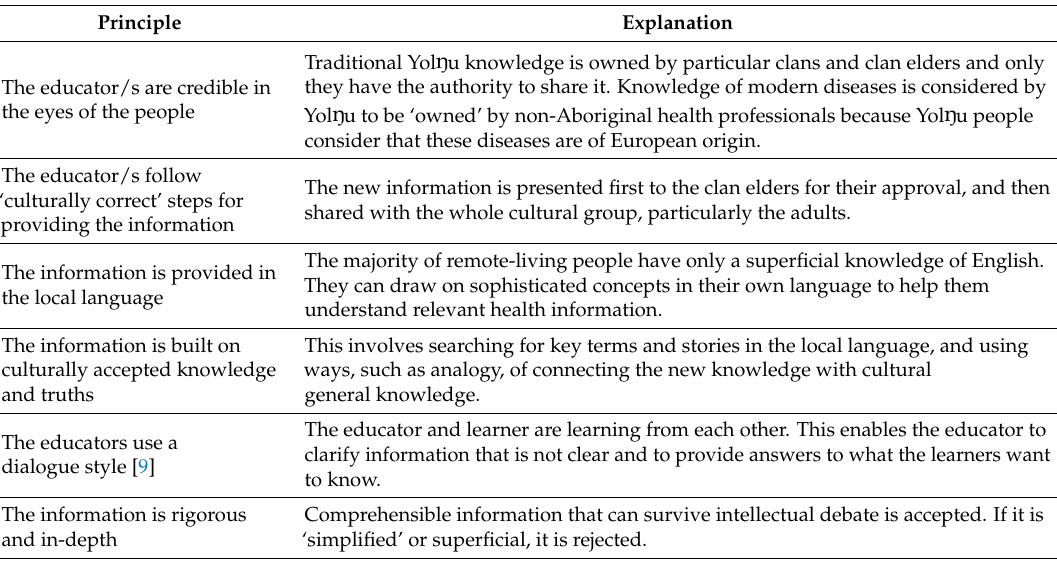
Table 1. Principles of Discovery Education (Modified from Trudgen [14] (pp. 202–210).